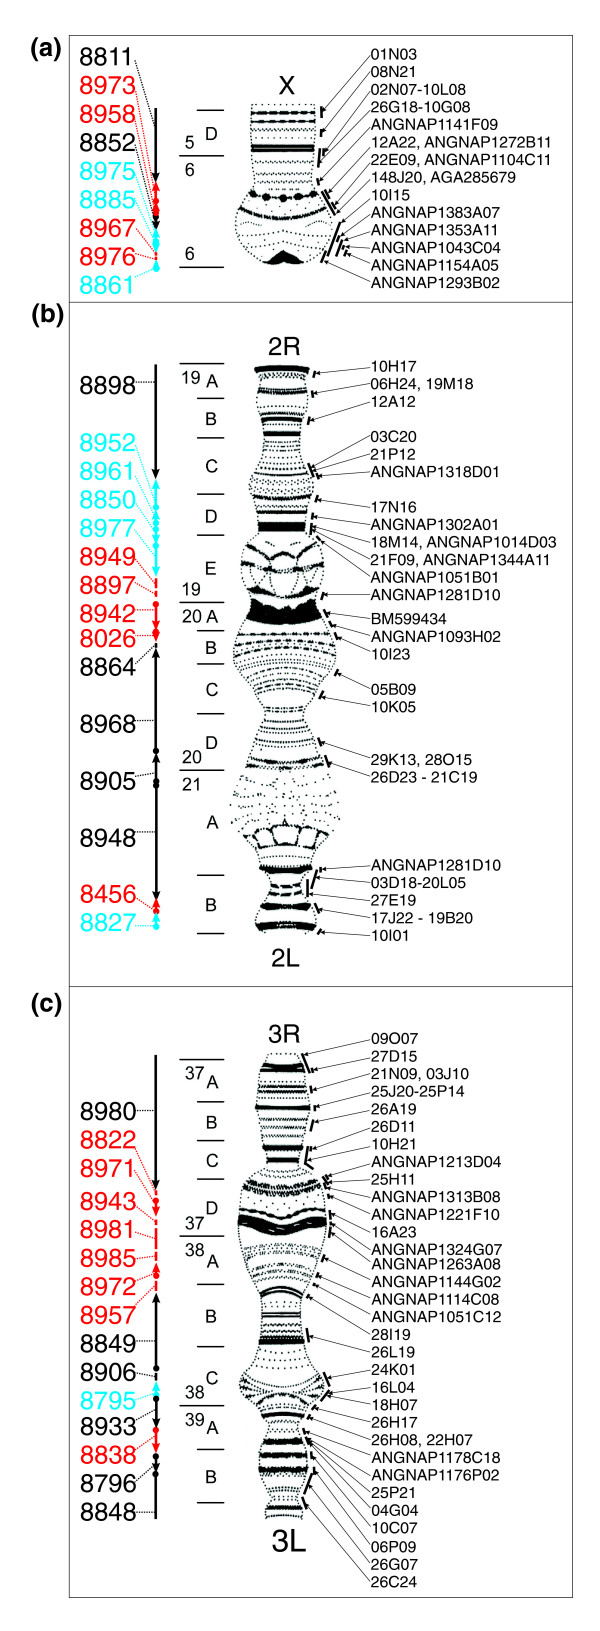
Scaffolds located in pericentromeric regions on A. gambiae chromosomes. Black and red lines and arrows on the left side of the picture correspond to the scaffolds previously and newly mapped to the pericentromeric regions of chromosomes (a) X, (b) 2 and (c) 3, respectively; blue arrows indicate newly oriented scaffolds. The dots on the arrows show the beginning of the scaffolds and the arrowheads correspond to the end of the scaffolds. The scaffolds are identified by the last four digits of the scaffold ID. The scale on the left side of the chromosomes indicates divisions and subdivisions in these regions. Black arrows on the right side of the picture show the location of the PCR amplified gene-fragments and BAC and cDNA clones.